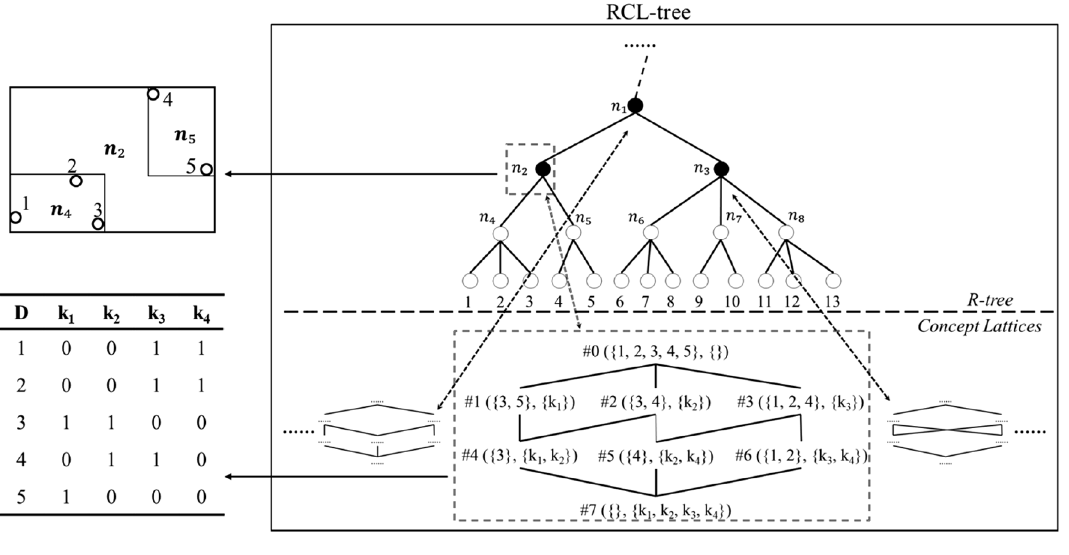
Figure 3. An example of